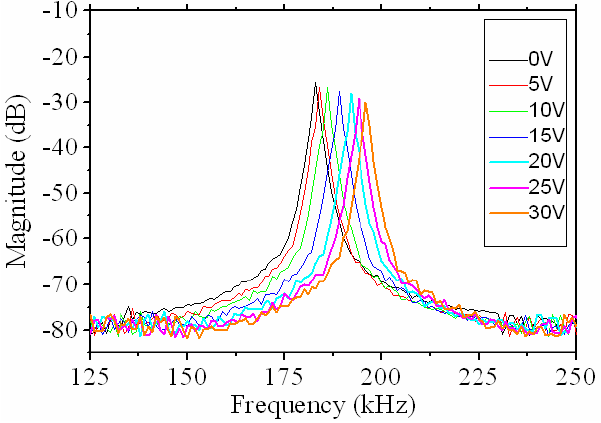
Figure 13. Frequency response of the tunable resonator at different tuning voltages.